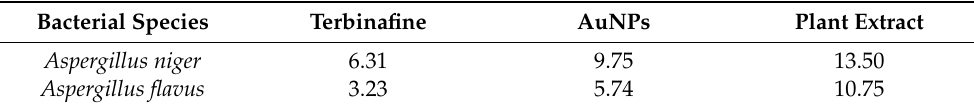
Table 6. Minimum inhibitory concentration of extract and its mediated AuNPs.